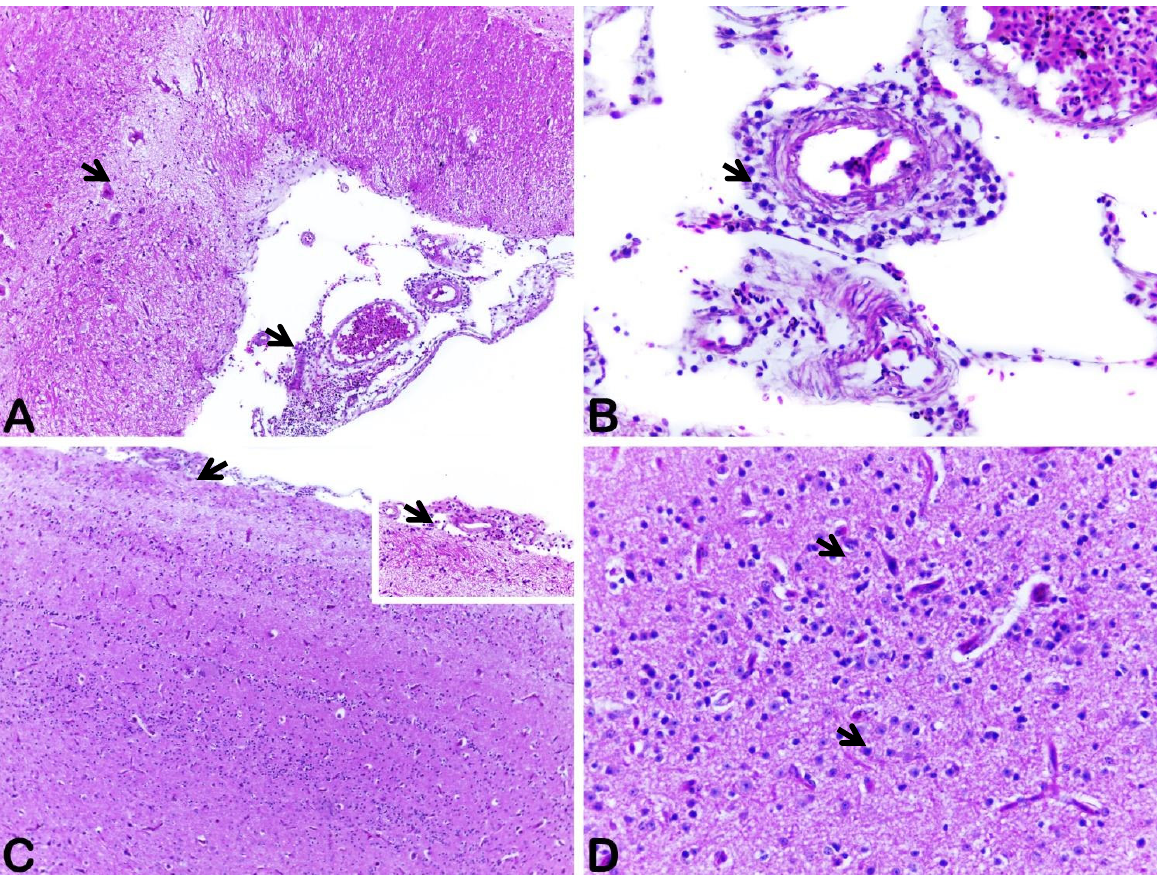
Figure 1. Severe lymphoplasmacytic inflammatory infiltrate expanding the perivascular space and severe vasculitis in leptomeningeal vessels (arrows). Note moderate diffuse vacuolization in the neuropil of the occipital cortex. HE staining, objective magnification 10× ( A ). Blood vessels from the leptomeninges presenting perivascular cuffs are composed mainly of lymphocytes, plasma cells, and rare macrophages (arrows). HE staining, objective magnification 40× ( B ). Mild infiltration of lymphocytes inflammatory cells in the meningeal space and superficial cortex (arrows), mainly composed of lymphocytes, plasma cells, and a few macrophages, diffuse severe gliosis in the inner gray matter. HE staining, objective magnification 10× ( C ). Higher magnification of C where diffuse gliosis and neuronal necrosis are characterized by shrunken, eosinophilic, and pyknotic neurons (arrows). HE staining, objective magnification 40× ( D ).